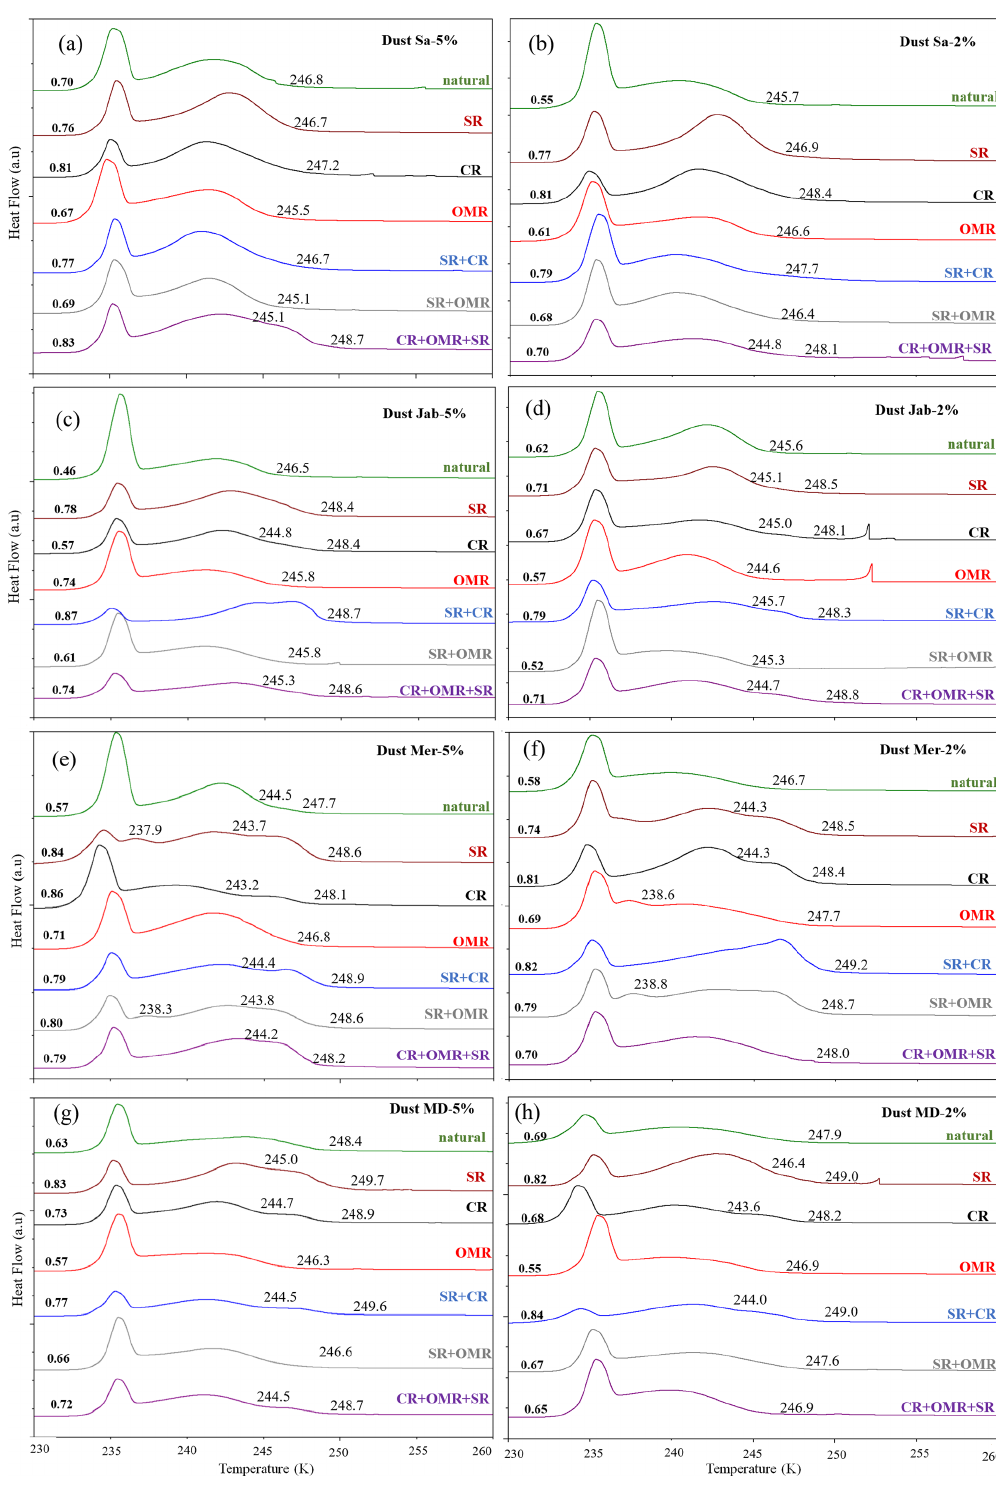
Figure 3. DSC thermograms of treated dust samples with 5wt% (a, c, e, g) and 2wt% (b, d, f, h) concentrations in comparison with the untreated samples. SR: salt removed; CR: carbonate removed; OMR: organic matter removed; SR + CR: salt and carbonate removed; SR + OMR: salt and organic matter removed; SR + CR + OMR: salt, carbonate, and organics removed. T het in Kelvin and F het in fraction are displayed directly on the